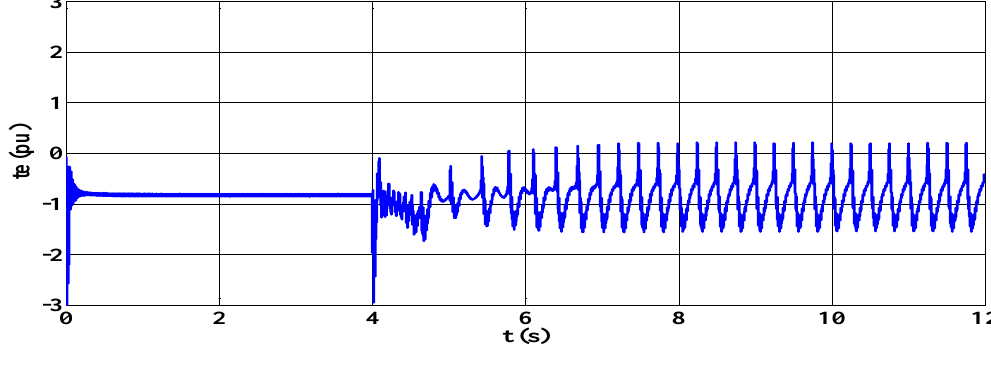
Figure 23. Electromagnetic torque (short-circuit happens at t = 4 s).